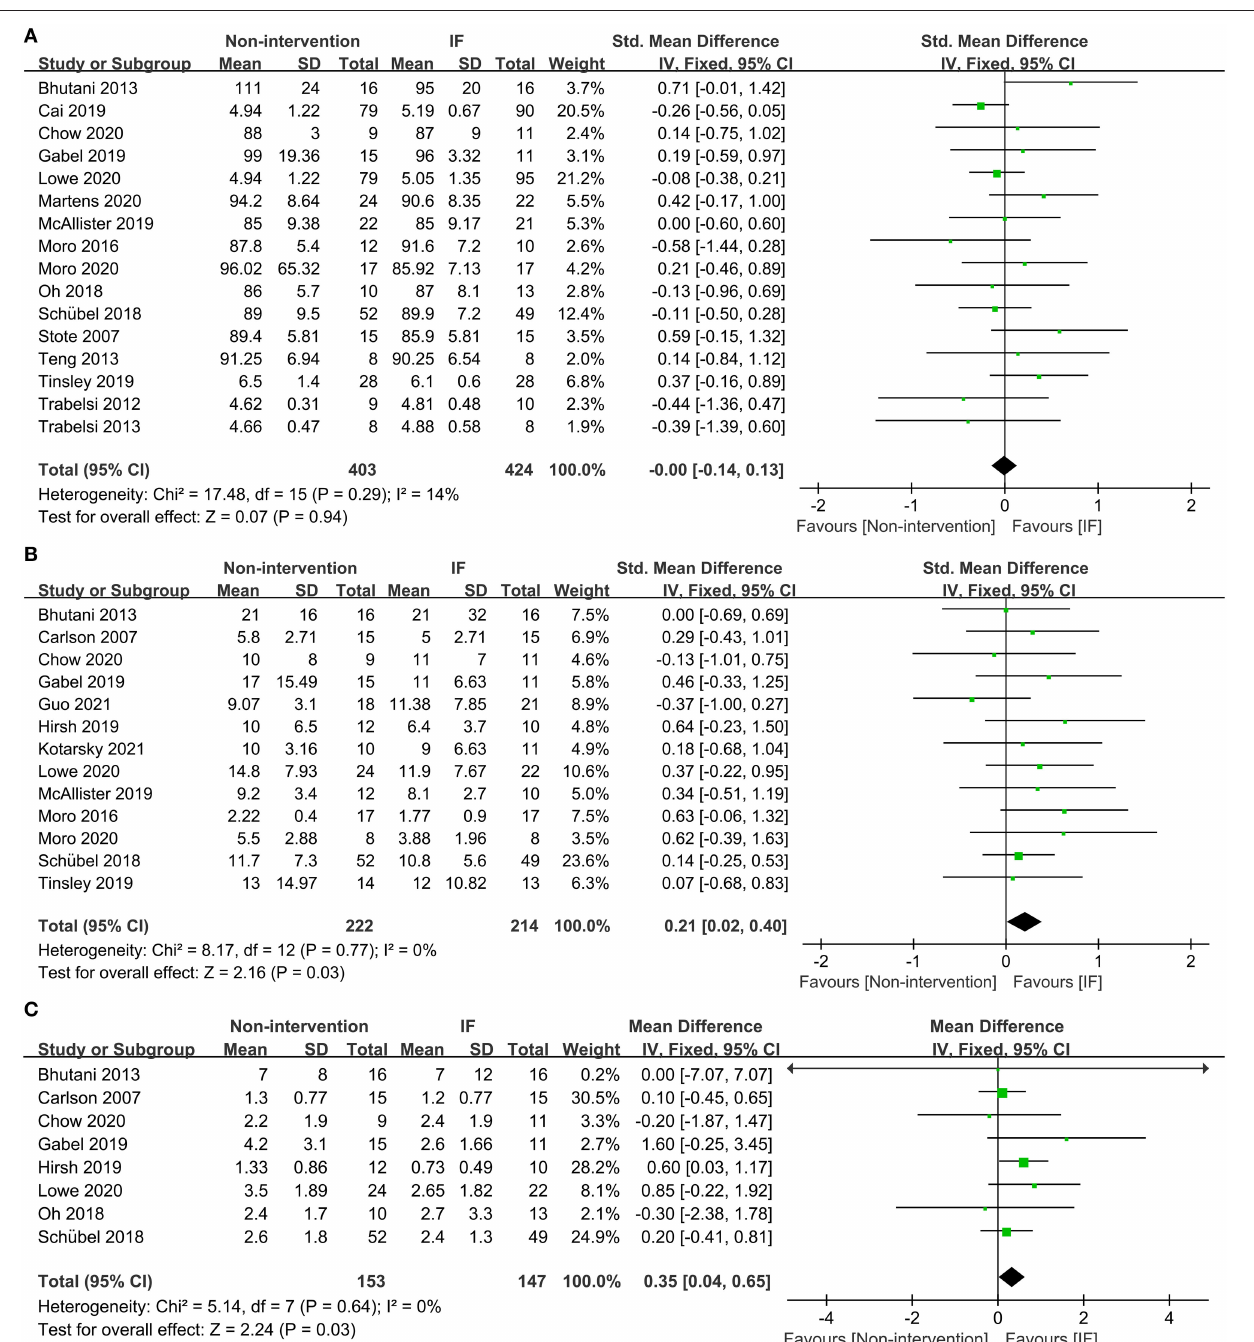
FIGURE 4 | Forest plots for the glucose, insulin, and homeostasis model assessment insulin resistance (HOMA-IR) of IF vs. non-intervention diet. (A) Glucose; (B) insulin; (C) HOMA-IR.